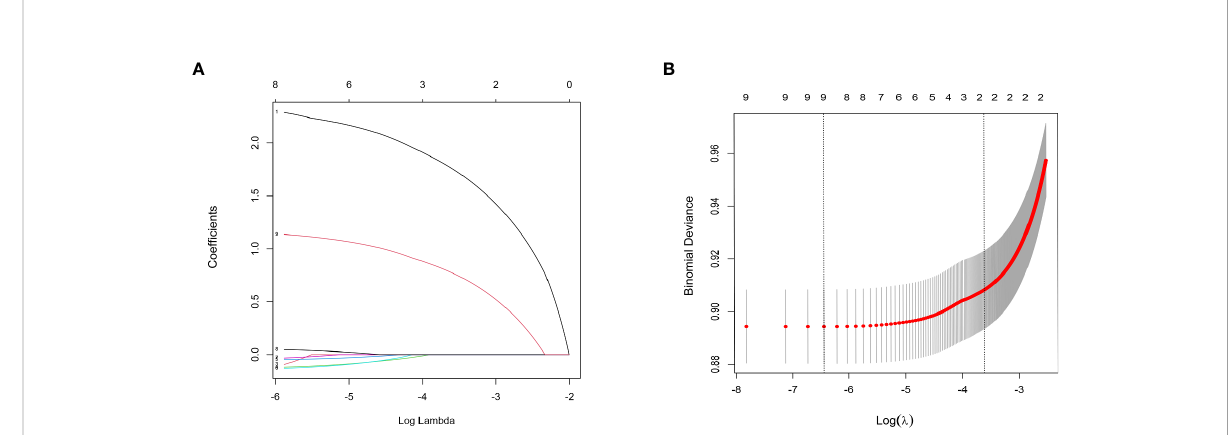
FIGURE 2 LASSO regression analysis was used to screen out factors associated with LNM. Analysis of T 1-2 -stage CC: (A) LASSO coef fi cients 1.M stage 2. Liver metastasis 3. Lung metastasis 4. Tumor size 5. Marital status 6. Age 7. Race 8. Grade 9. T stage; (B) Selection of the tuning parameter ( l ).